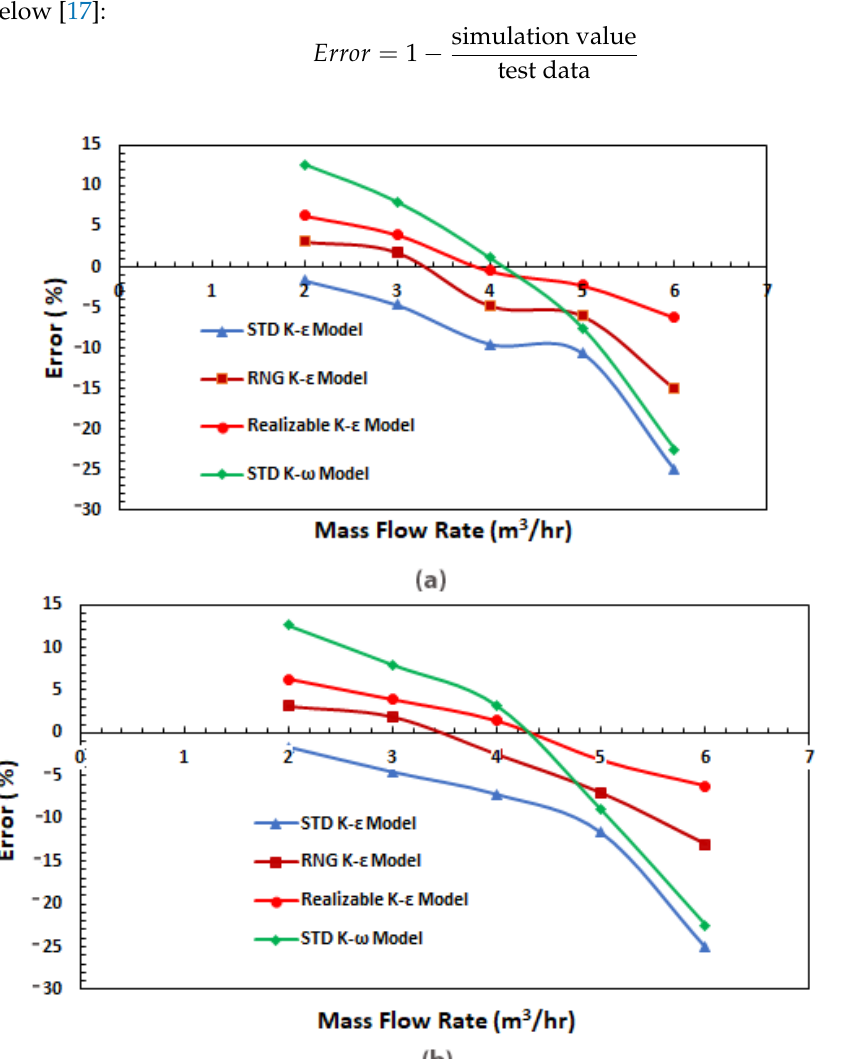
Figure 10. Comparison of error percentage among different turbulence models at varying mass flow rates. ( a ) Error percentage of head ( b ) Error percentage of efficiency.